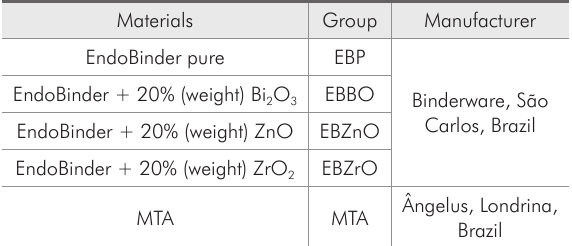
Table 1 - Cements used in the